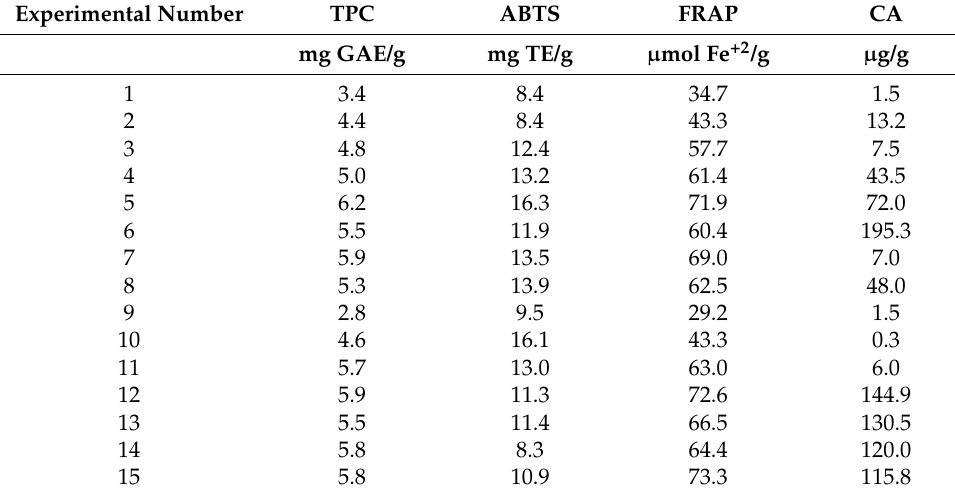
Table 3. Experimental values of TPC, ABTS, FRAP, and CA of MAE extracts.